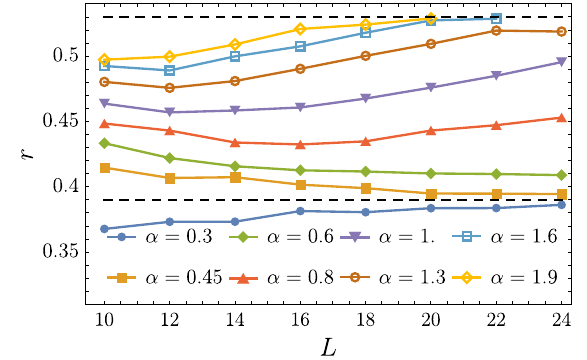
FIG. 6. The average r parameter as a function of L for different values of α . From top to bottom (for any fixed L ), α ¼ 1 . 9 , 1.6, 1.3, 1, 0.8, 0.6, 0.45, 0.3. The dashed lines at r ¼ 0 . 53 and r ¼ 0 . 39 represent the WD and Poisson values, respectively. Error bars are within the symbol.